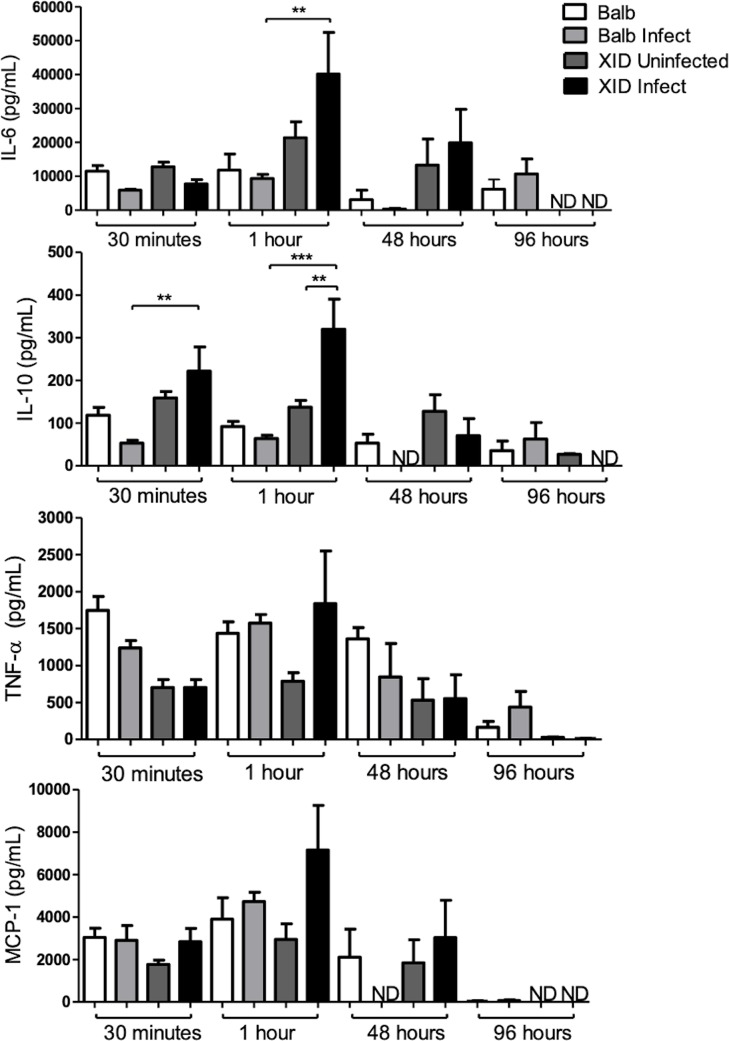
Cytokines levels in the supernatants of BALB/c and XID APerC at 30 minutes, 1 hour, 48 and 96 hours.Data are represented as mean ±SEM (** P <0.01, *** P <0.001and ND = not detected, One-way ANOVA with multiple comparisons and Tukey post-test).